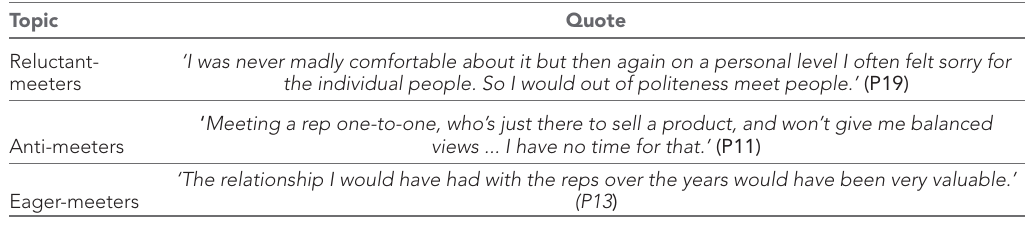
Table 4 Illustrative quotes on why GPs’ attitudes towards meetings with pharmaceutical